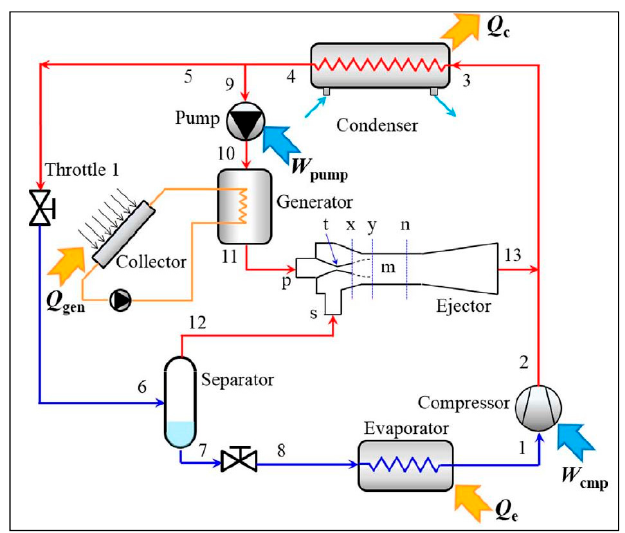
Figure 30. Solar-activated ejector–compressor hybrid system [317].